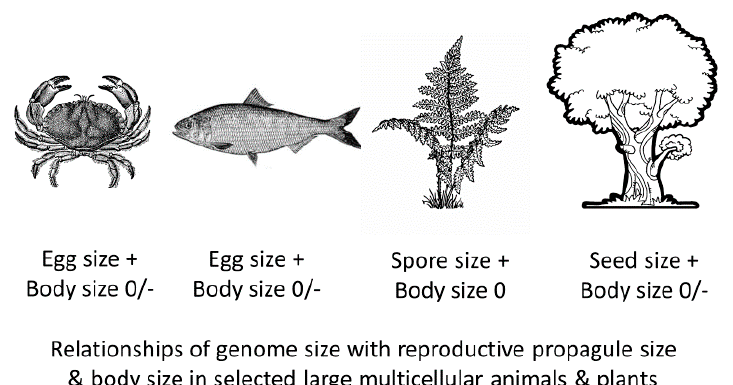
Figure 4. Representative pictures of relatively large multicellular organisms, including decapod crustaceans, bony fishes, ferns and flowering plants [232–235] that show positive (+) relationships between genome size and reproductive propagule size, but no (0) or weakly negative ( − ) relationships with adult body size (Tables 1 and 2), largely following predictions #1, #3 and #4 of the Single-Cell ‘Bottleneck’ Hypothesis (SCBH: Table 6). These relationships occur apparently because genome size is more related to cell size (including the cells of eggs, spores and seeds) than to cell number (which mainly determines the various sizes of relatively large organisms) (following assumptions #2–#5 of the SCBH: Table 6).